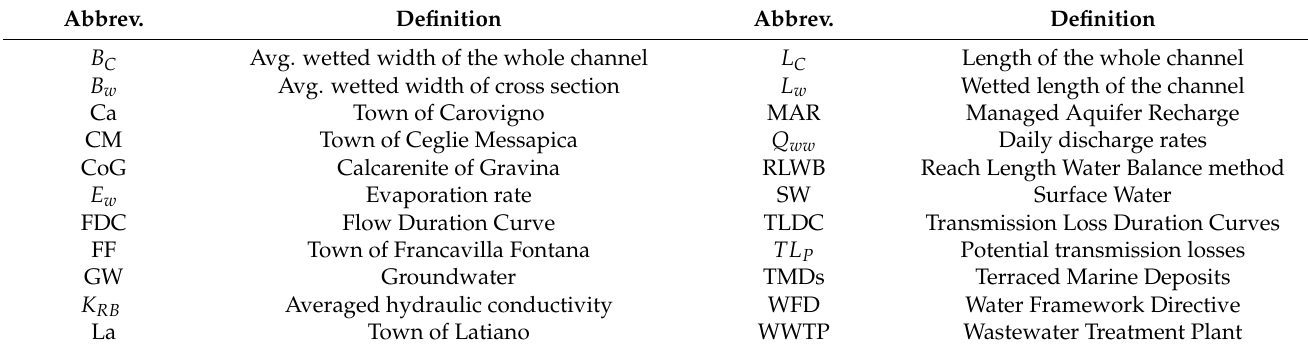
Table 1. List of abbreviation used in the paper reported